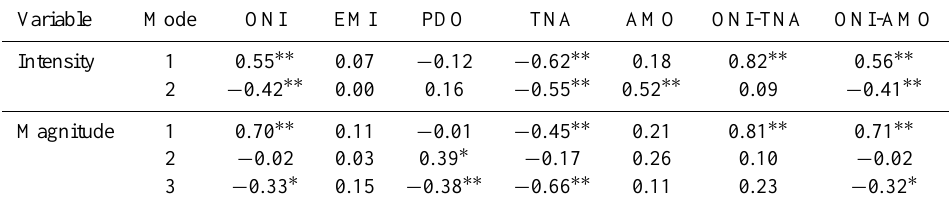
Table 4. Correlations between X mode times series and Oceanic El Niño Index (ONI, NOAA, 2016), El Niño Modoki Index (EMI, JAM- STEC, 2016), Pacific Decadal Oscillation (PDO, NOAA, 2016), Tropical North Atlantic (TNA, NOAA, 2016), and Atlantic Multidecadal Oscillation (AMO, NOAA, 2016). The differences ONI-TNA and ONI-AMO are calculated with the normalized indexes. Correlations are marked with * and ** for 0.05 and 0.01 of significance level